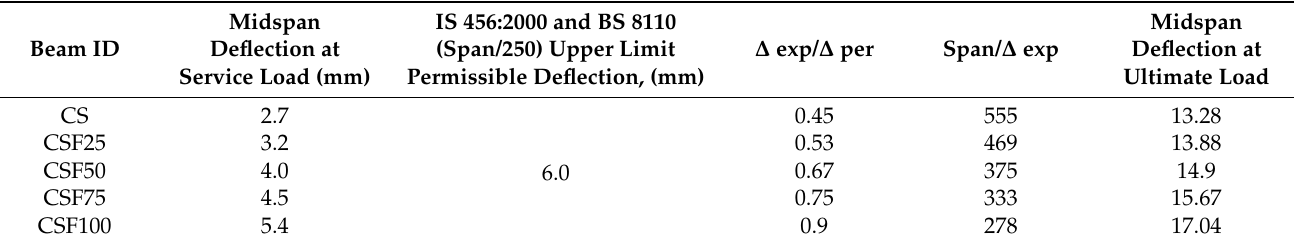
Table 4. The deflection of the